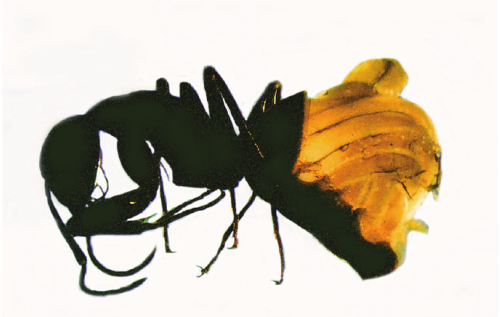
Figure 1: Mermithid exposed in the gaster of Camponotus sp. from the Sierra Nevada, California.